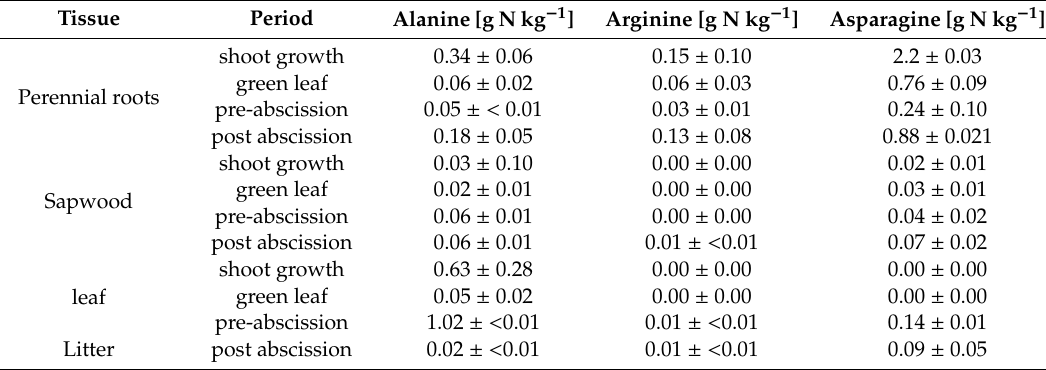
Table 3. Amino acid content in di ff erent tissues of Fagus crenata Blume ( n = 3). Only amino acids found in significant amounts were reported with ± denoting SD.